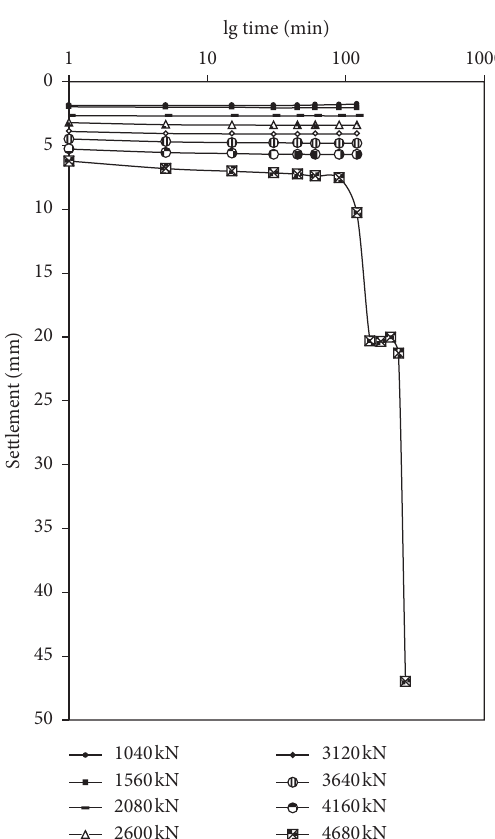
Figure 18: s-lgt curve of